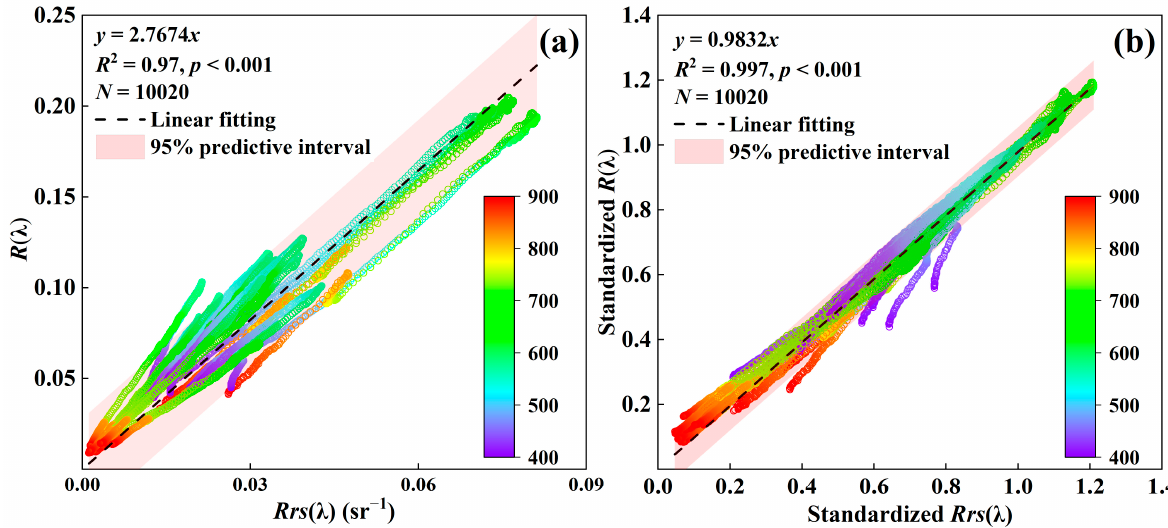
Figure 4. Linear regression between Rrs ( λ ) and R ( λ ) from 400 to 900 nm before ( a ) and after ( b ).